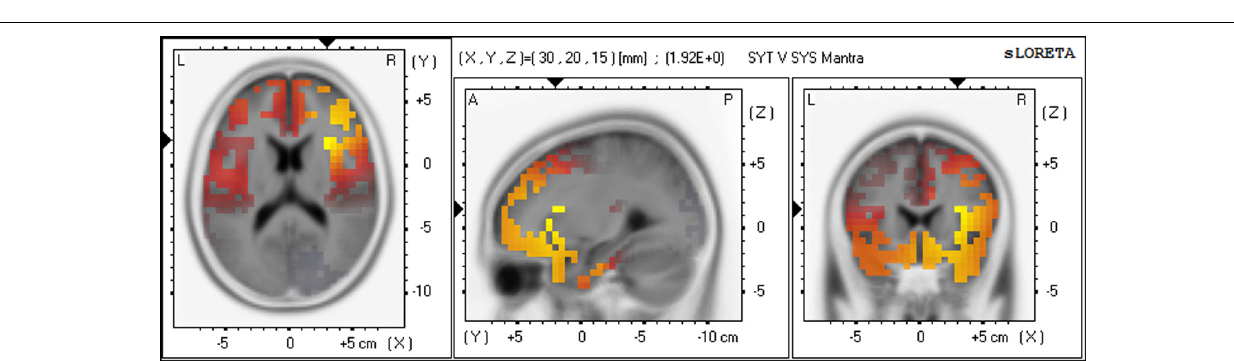
bands for Meditation 1 (Body-steadiness) and theta and alpha 1 for Meditation 2 (Mantra). In both meditations the